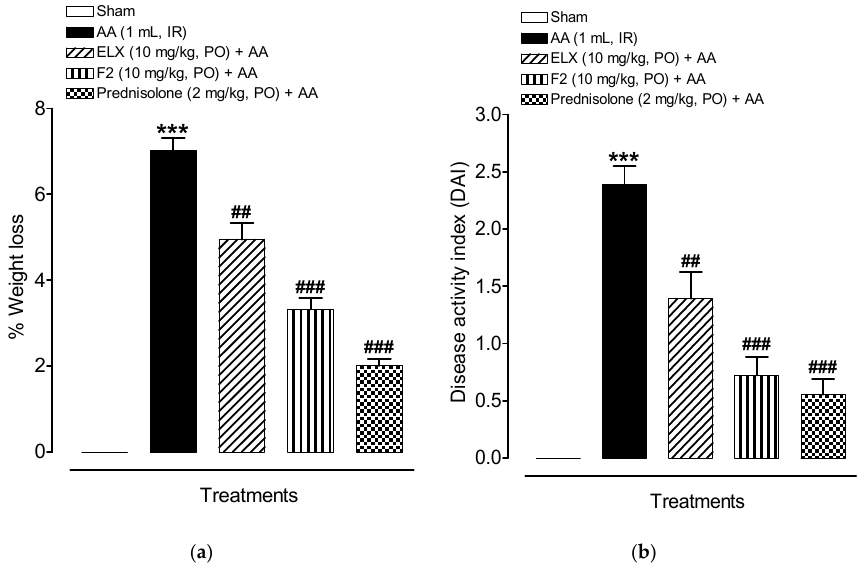
Figure 6. Pretreatment with ELX and F2 improved percentage of ( a ) weight loss and ( b ) disease activity index (DAI) in Wistar albino rats induced with AA colitis. Data are represented as means ± SEM ( n = 6). *** p < 0.001 compared with sham group; ## p < 0.01, ### p < 0.001 compared with AA alone. ELX = Eluxadoline, F2 = formulation, AA = acetic acid; PO = orally; IR = intrarectally. Note: Normal stools = well-formed pellets, loose stools = pasty and semi formed stools which do not stick to the anus, and diarrhea = liquid stools that stick to the